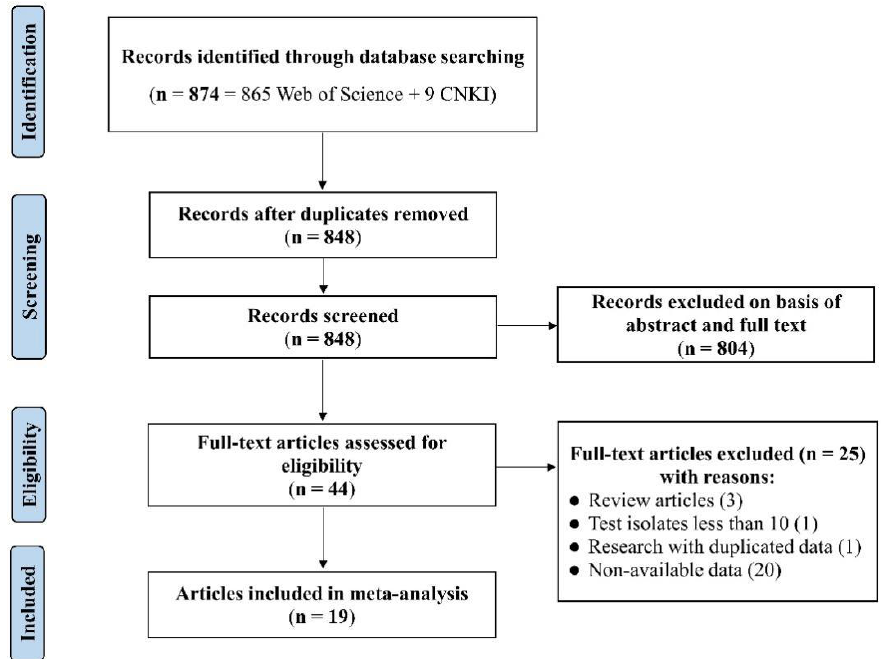
Figure 1. PRISMA flowchart diagram for the selection process of eligible studies.